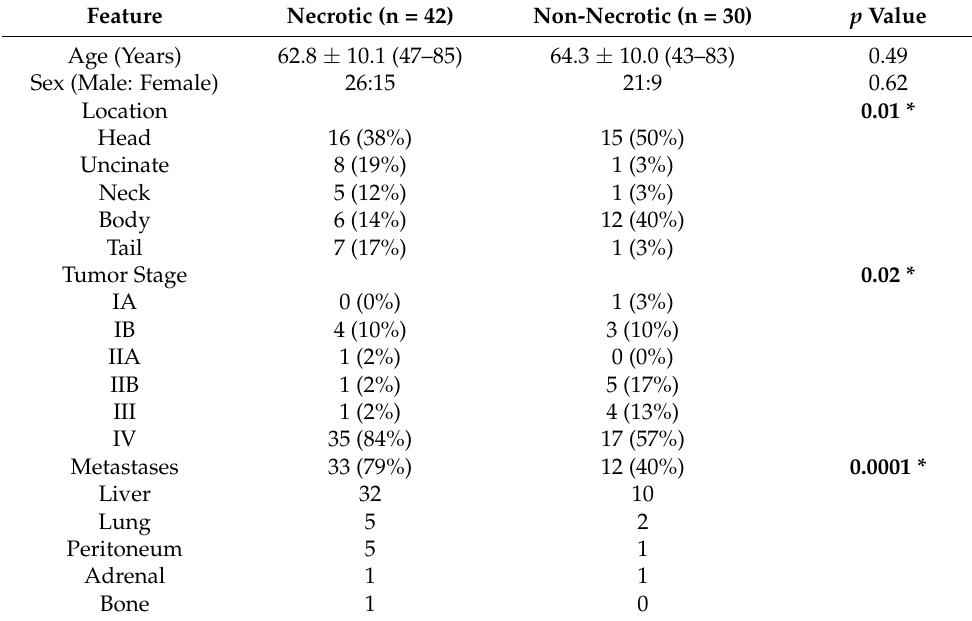
Table 1. Comparison of patient and tumor characteristics between necrotic and non-necrotic pancre- atic ductal adenocarcinomas. Feature Necrotic (n = 42) Non-Necrotic (n =